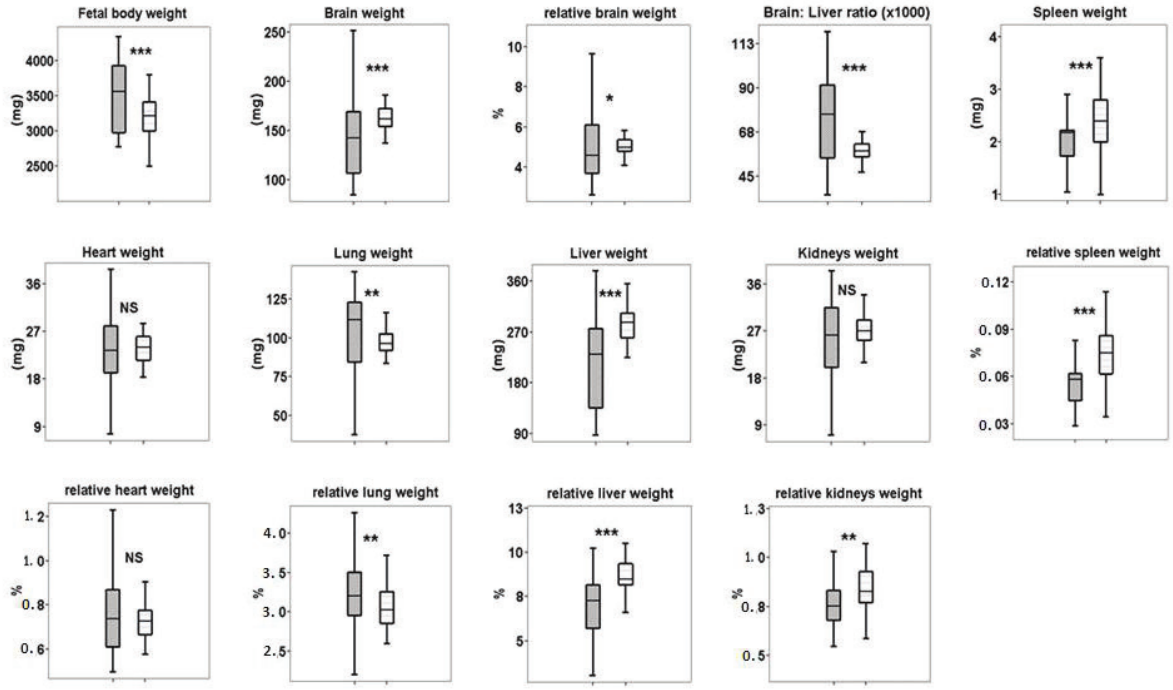
Figure 3. Viscera weights of fetuses from pregnant rats treated with a daily dose of 300 µg/kg of Buthus occitanus tunetanus venom (striped boxes) or 1 mL/kg of saline solution (white boxes), from the 7 th to the 13 th day of gestation ( median, 25%-75%,